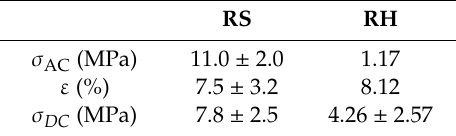
Table 8. Averaged results of axial and diametral compression tests for RS and RH